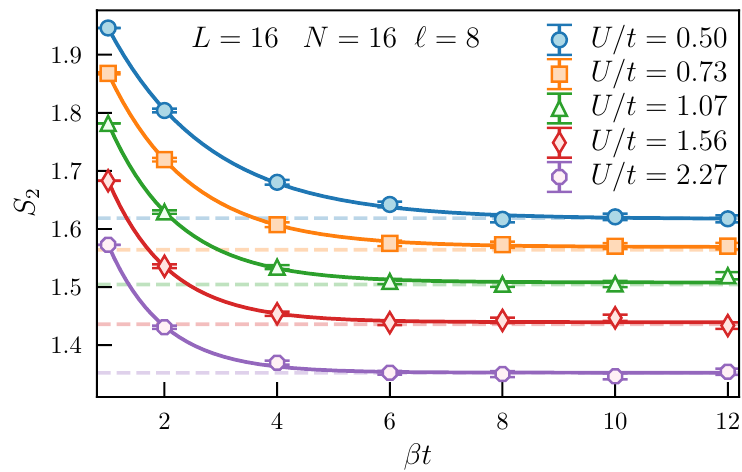
Figure 21: Full second Rényi Entropy for a one-dimensional lattice of L = 16 sites at unit-filling under an equal spatial bipartition of size ℓ = 8. Three-parameter ex- ponential fits in β t (solid lines) have been performed on the Monte Carlo results (markers). The dashed horizontal lines denote exact diagonalization values for each of the various interaction strengths. The three-parameter exponential fits the data well and can be used to extrapolate the large β limit results of measurements of in-